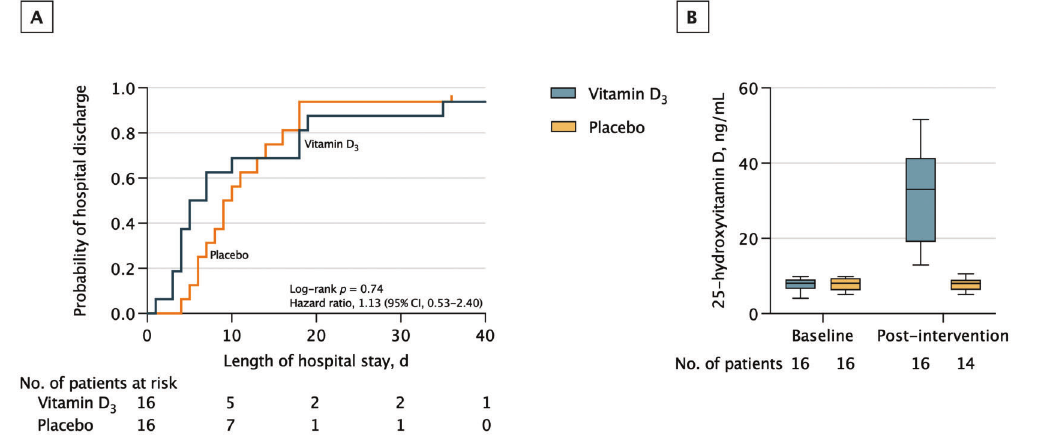
Figure 1 - Hospital discharge and serum 25-hydroxyvitamin D levels. A, Vertical bars represent single censored events. The median (interquartile range [IQR]) observation time was not significantly different between the vitamin D 3 group (6.0 [4.0–18.0] days) and the placebo group (9.5 [6.3–15.5] days) (log-rank p =0.74; HR for hospital discharge, 1.13 (95% confidence interval [CI], 0.53–2.40; p =0.76). B, 25-hydroxyvitamin D levels measured on the day of randomization (baseline) and on hospital discharge (post-intervention). A single high dose of vitamin D 3 significantly increased 25-hydroxyvitamin D levels compared with the placebo (difference, 23.9 ng/mL [95% CI, 17.7–30.1]; p o 0.001). The median IQR observation time of the post-intervention period was 6.0 (4.0–18.0) days for the vitamin D 3 group and 9.5 (6.3–15.5) days for the placebo group. Intention-to-treat analysis was